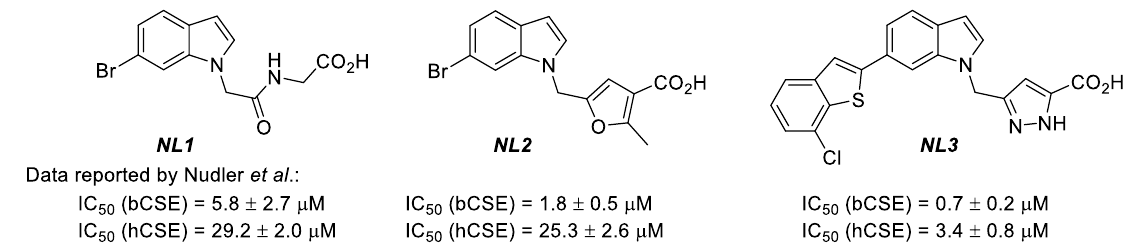
Figure 1. NL1, NL2, and NL3 inhibitors of the bacterial cystathionine γ-lyase (bCSE). IC 50 data was reported by Nudler et al. [3].